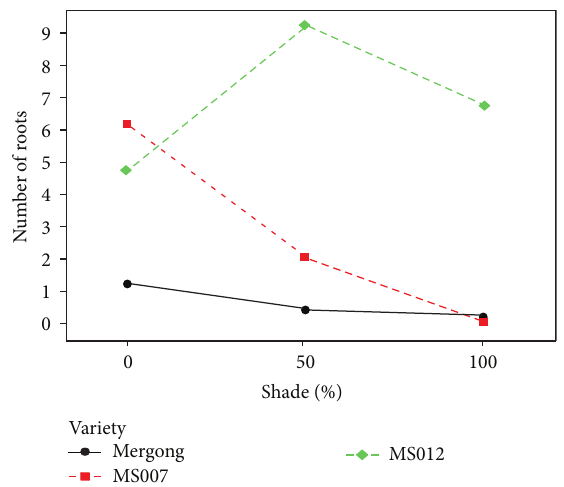
Figure 3: Interactions between varieties and shade treatments in root number on day